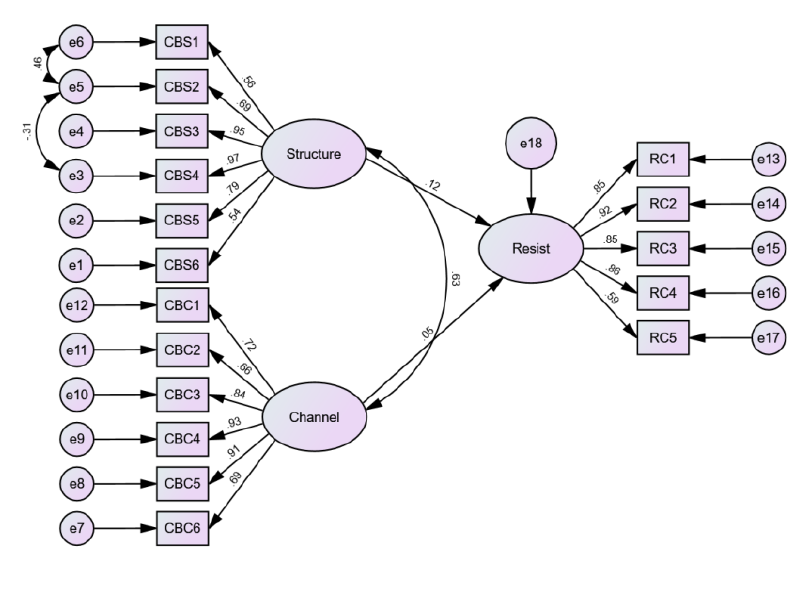
Figure 2: SEM model showing the relationship among the constructs in the proposed